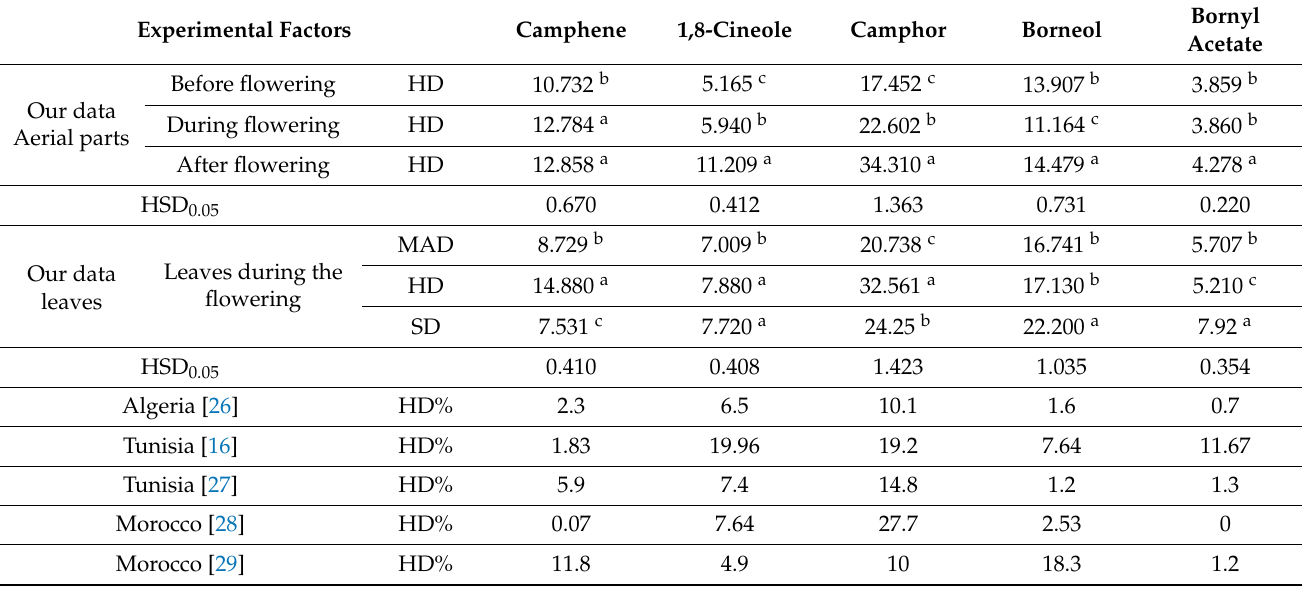
Table 4. Major compounds of essential oil Thymus algeriensis